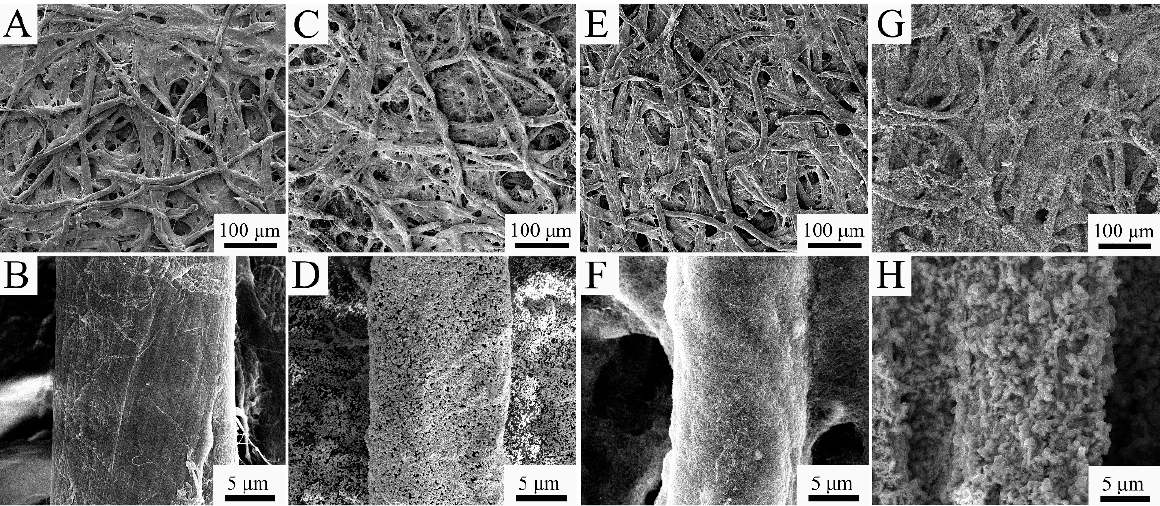
Figure 1. SEM images of bare paper ( A , B ), Au–PAE ( C , D ), CNT–PCE ( E , F ) and MIPs–Au–PAE ( G , H ).